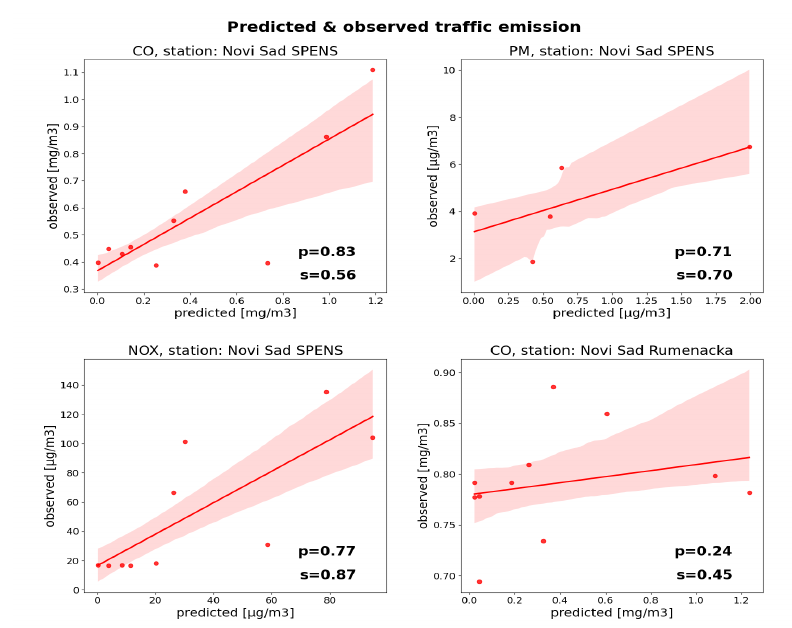
Figure 8. Validation—Pearson (p) and Spearman (s) correlation coefficients between predicted and observed emission in air quality stations. The selected day—6 November 2019 Please note: there were interruptions in measurements of PM at the Novi Sad Spens station. Moreover, the axes are not in the same scale to emphasize the captured trend.